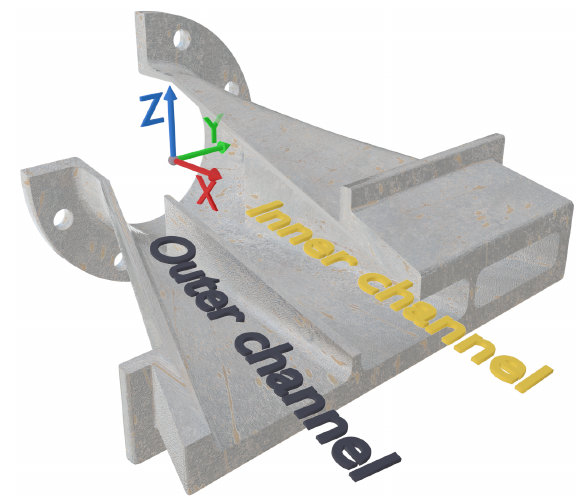
Figure 7. Nomenclature for results and axes